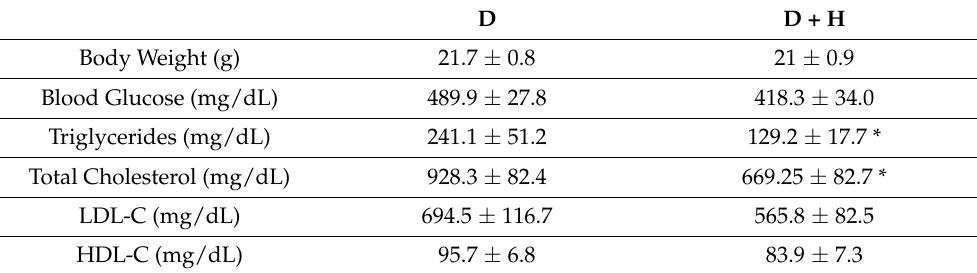
Table 2. Effect of hidrosmin on metabolic parameters in diabetic ApoE KO mice. Data are expressed as mean ± SEM of each group (untreated (D), n = 7; hidrosmin treatment (D + H), n = 11). * p < 0.05 vs. D group by Mann–Whitney U test. Abbreviations: LDL-C, LDL cholesterol; HDL-C, HDL